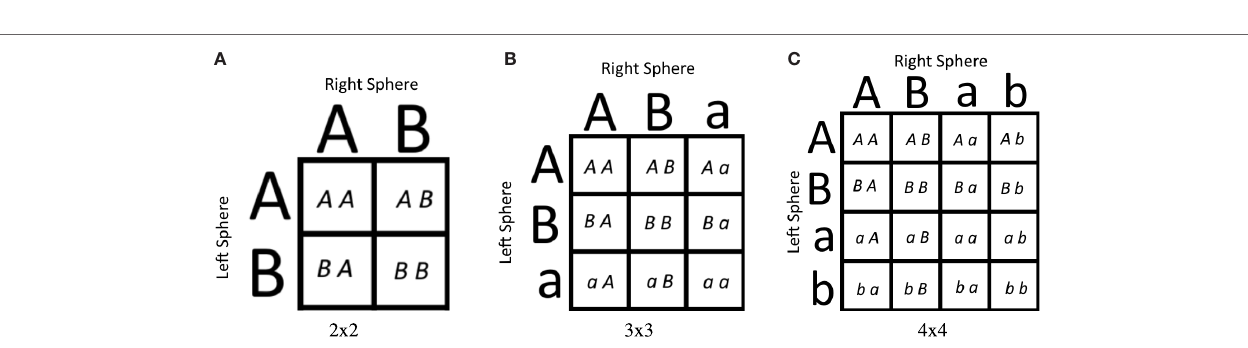
FIGURE 2 | Drawings of desired behavior for the modular morphology (A) and non-modular morphology (B) in each of the four environments in the 2 (cid:2) 2 . Arrows indicate desired movement away from the base position (the base position is shown in the top left panels). Gray segments and arrows indicate other acceptable behaviors.